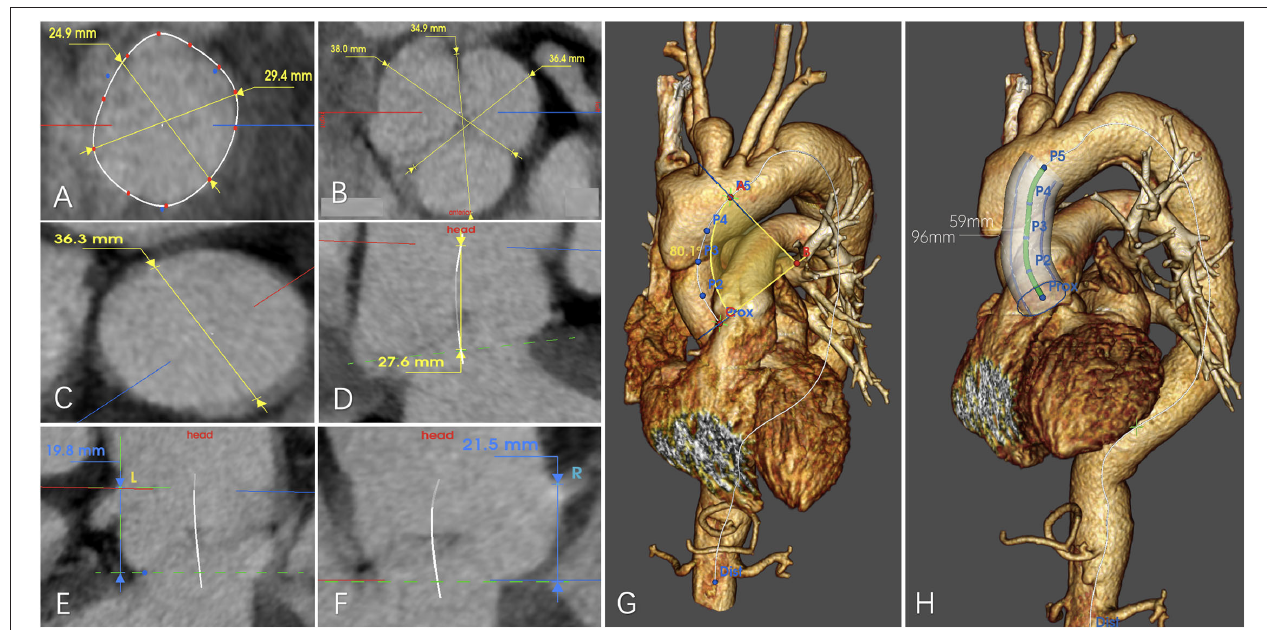
FIGURE 1 | Example for anatomical measurement of (A) diameter of the aortic annulus, (B) diameter of the sinus of the Valsalva, (C) diameter of the sinotubular junction (STJ), (D) distance between the aortic annulus and the STJ, (E) Distance between the aortic annulus and the distal edge of the left coronary ostium, (F) distance between the aortic annulus and the distal edge of the right coronary ostium, (G) aortic radius of curvature, and (H) length between the STJ and the distal edge of the ostium of the innominate artery measured along the centerline/greater curvature side/lesser curvature